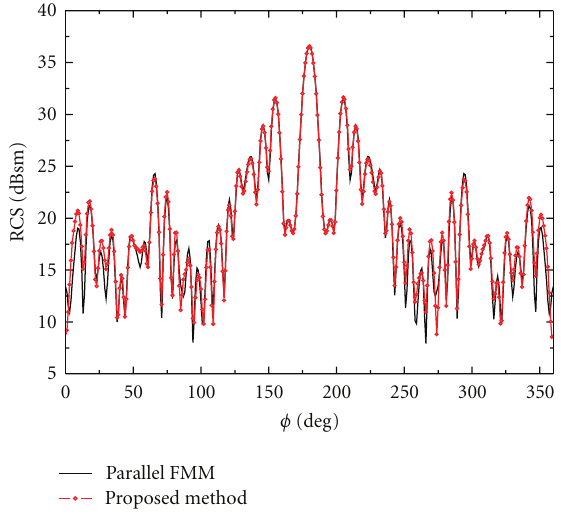
Figure 6: RCS pattern of the truncated cone. Frequency: 7GHz. Polarization: HH. Comparison with measurement.